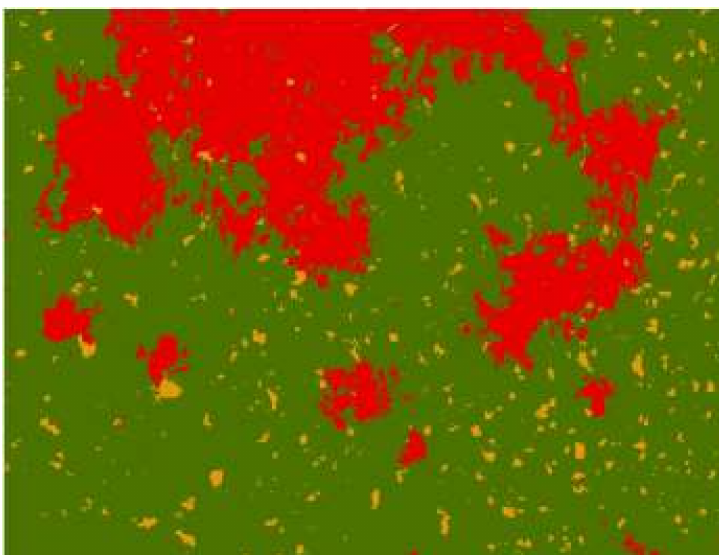
Figure 8. The predicted output of weakly supervised learning.